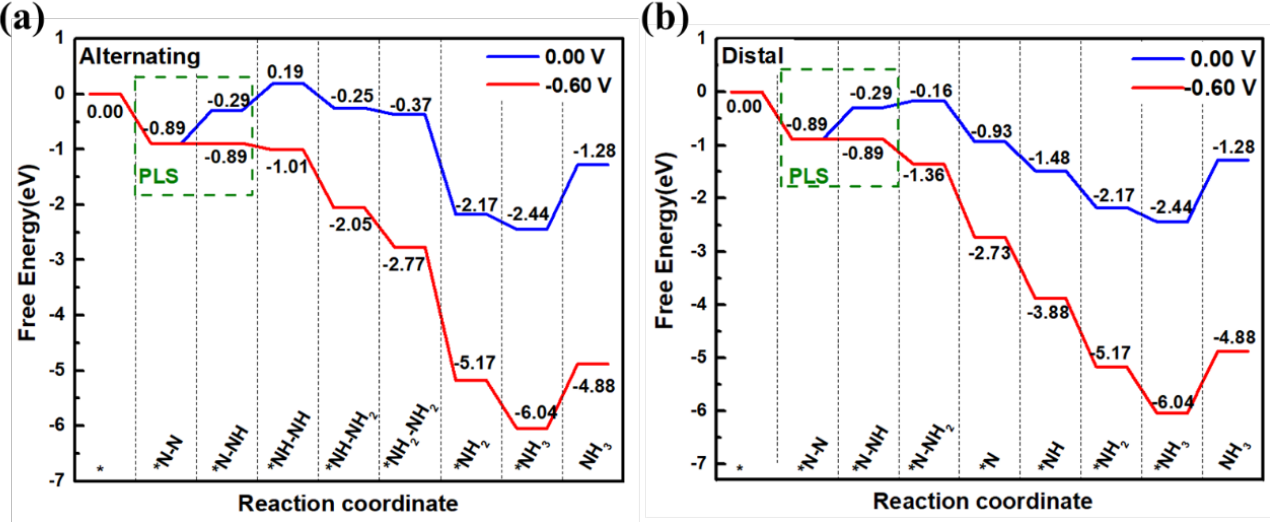
Figure 4. NRR free energy diagrams via ( a ) alternating ( b ) distal mechanisms for V@g-C 3 N 4 .